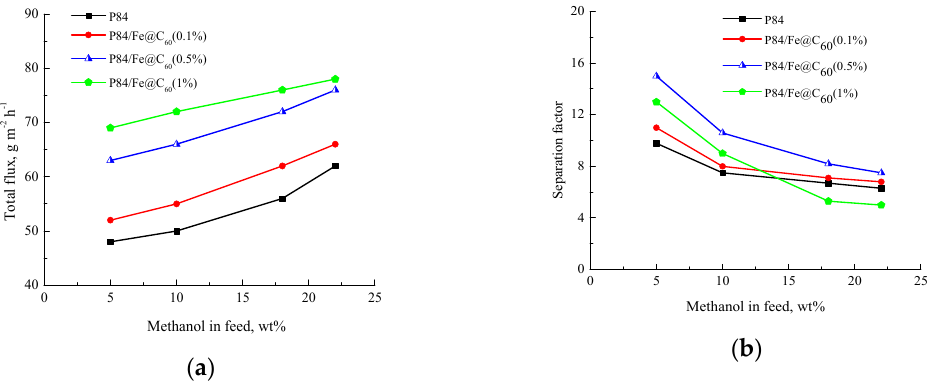
Figure 4. Dependence of ( a ) total flux and ( b ) separation factor α MeOH/MeOAc on methanol concentration in the feed for the pervaporation of the methanol—methyl acetate mixture through membranes based on P84 and P84/Fe@C 60 , 25 ° С .